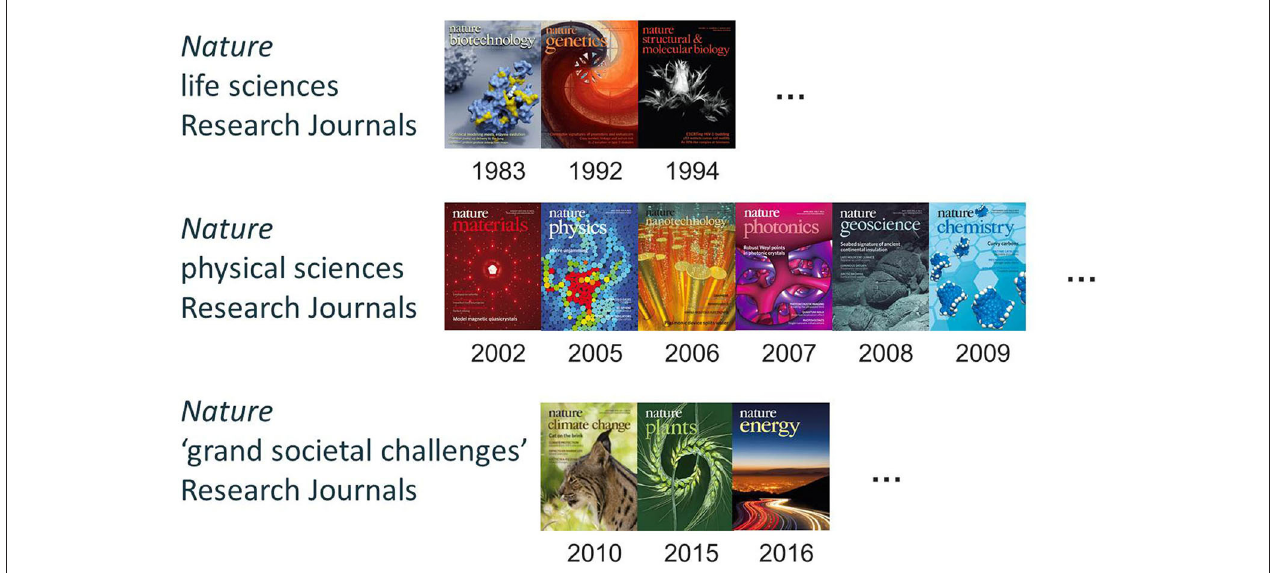
FIGURE 1 | Development of the Nature-branded journals portfolio, adapted from Verberck 2017. 2